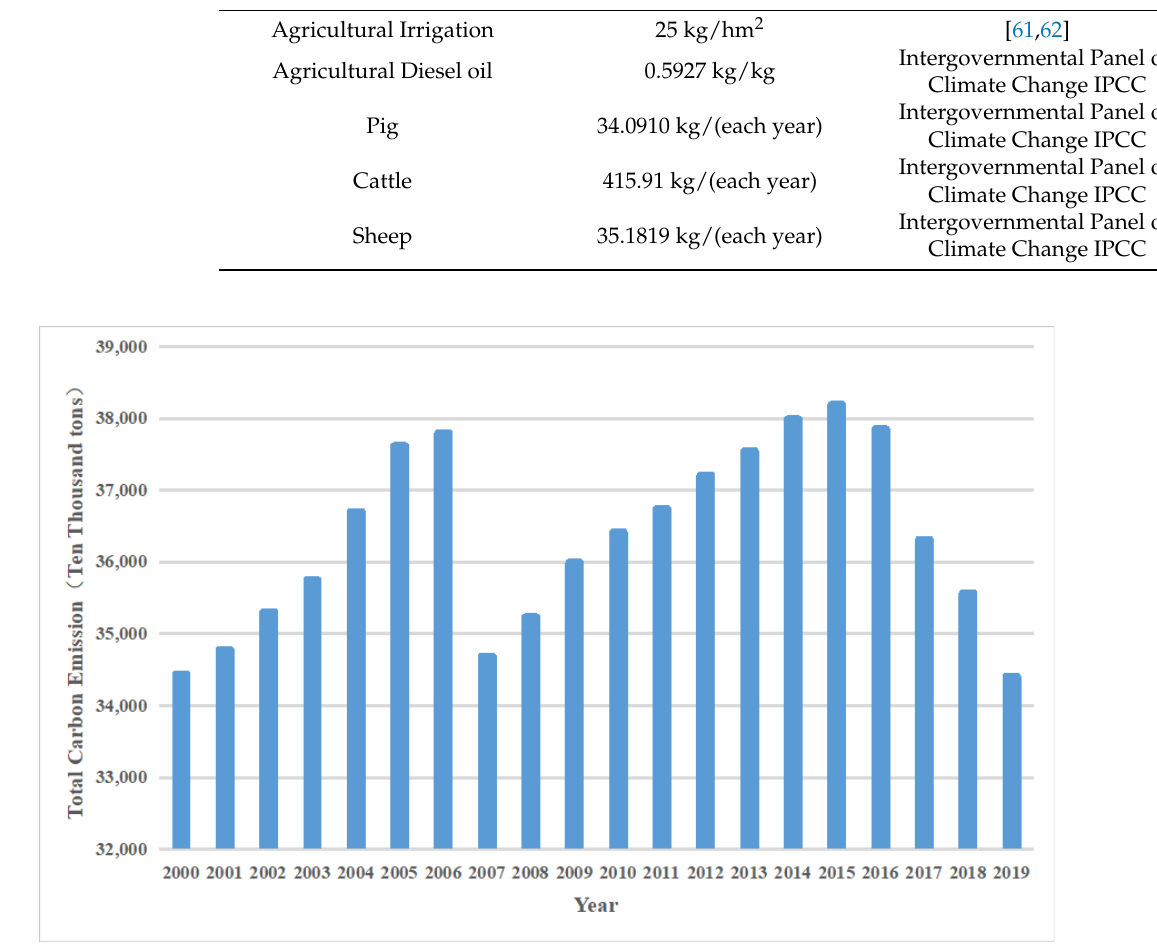
Figure 1. Carbon emissions from agricultural production from 2000 to 2019 in